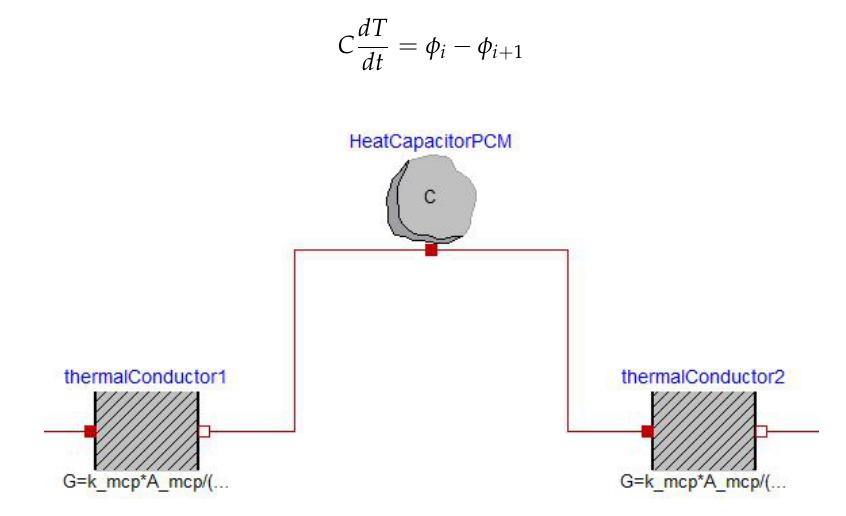
Figure 8. Model of a phase change material